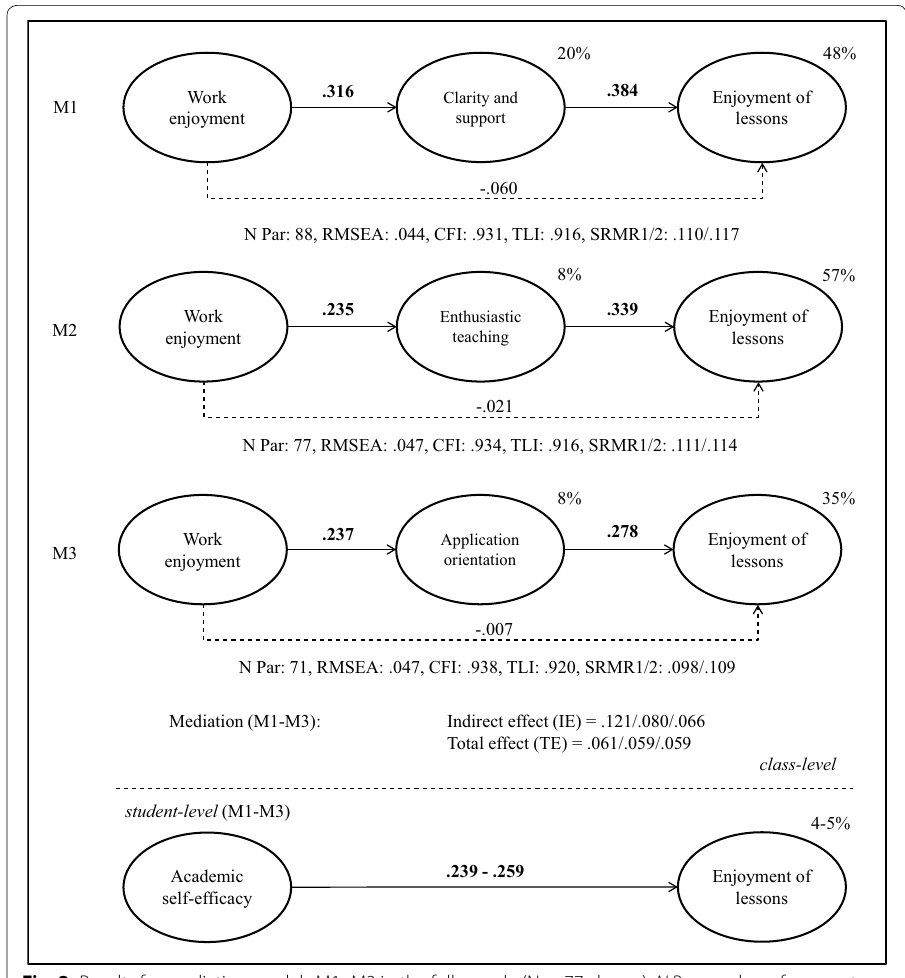
Fig. 2 Results for mediation models M1–M3 in the full sample (N RMSEA Root Mean Square Error of Approximation, CFI Comparative Fit Index, TLI Tucker Lewis Index, SRMR Standardized Root Mean Square Residual, SRMR1 SRMR within, SRMR2 SRMR between, values above ellipses: R 2 . Coefficients larger than the cut-off (>.200) are